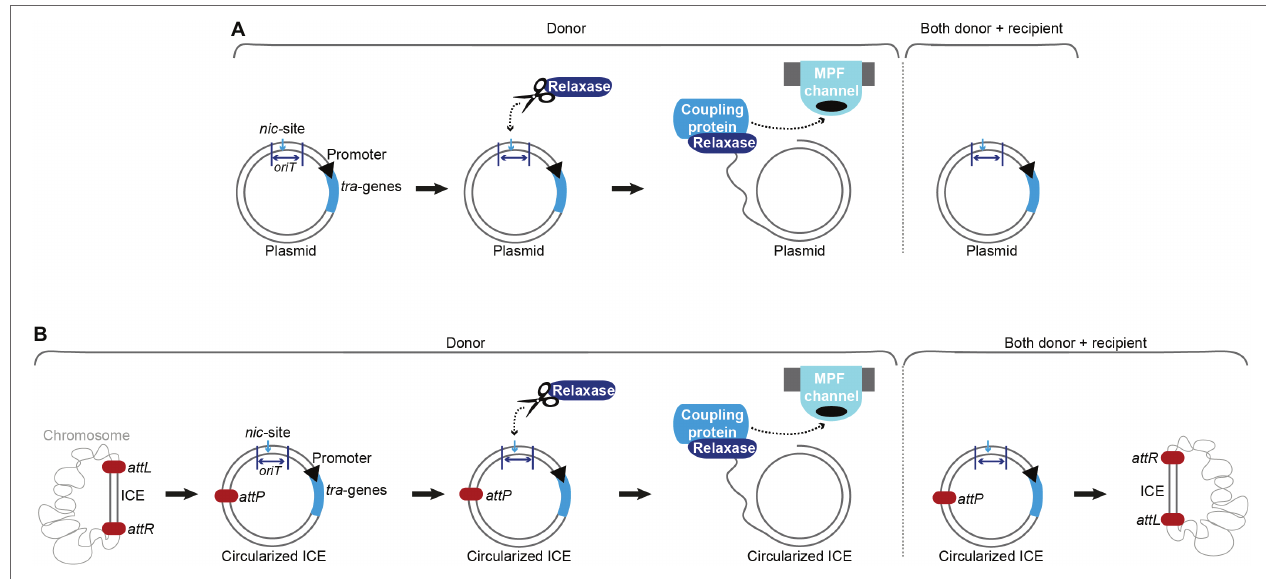
FIGURE 1 | Conjugation of plasmids and integrative and conjugative elements (ICEs). (A) Upon a signal (internal or external), the relaxase introduces a single- strand (ss) break at the nic -site of the origin of transfer ( oriT ) in the donor cell and covalently binds the ss-DNA. The coupling protein interacts with the relaxosome (relaxase, accessory factors and ss-plasmid DNA) and brings the relaxase-DNA complex to the mating pair formation (MPF) channel. The ss-DNA (most likely covalently bound by the relaxase) is shuttled to the recipient cell. In parallel, replication processes ensure that both donor and recipient harbor a double-stranded version of the conjugative plasmid. (B) With the aid of an excisionase and an integrase, the integrative and conjugative element (ICE) is excised from the host’s chromosome at attL and attR attachment sites, forming an attP site on the circularized ICE and an attB site on the bacterial chromosome. Processing of the DNA, transport and replication follow a comparable mechanism as described for conjugative plasmids in (A) . After successful conjugation and replication, the ICE is again integrated into the host’s